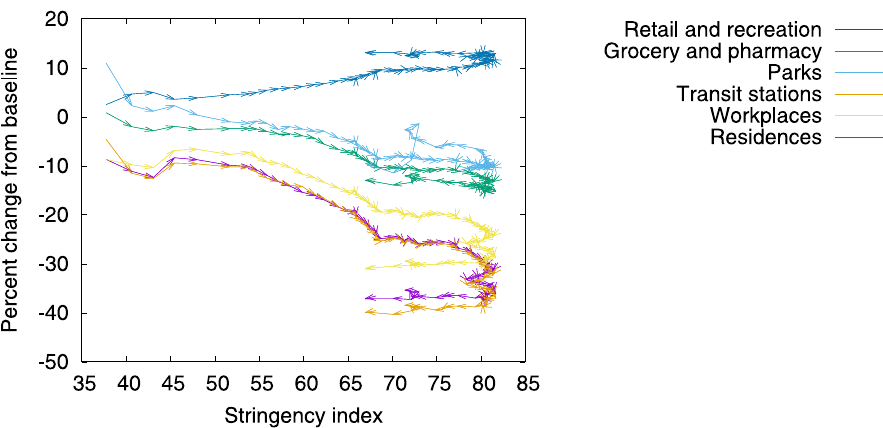
Fig 6. (Color online) community mobility change. Arrows correspond to the temporal dimension, that is, an arrow links two consecutive days of the outbreak.